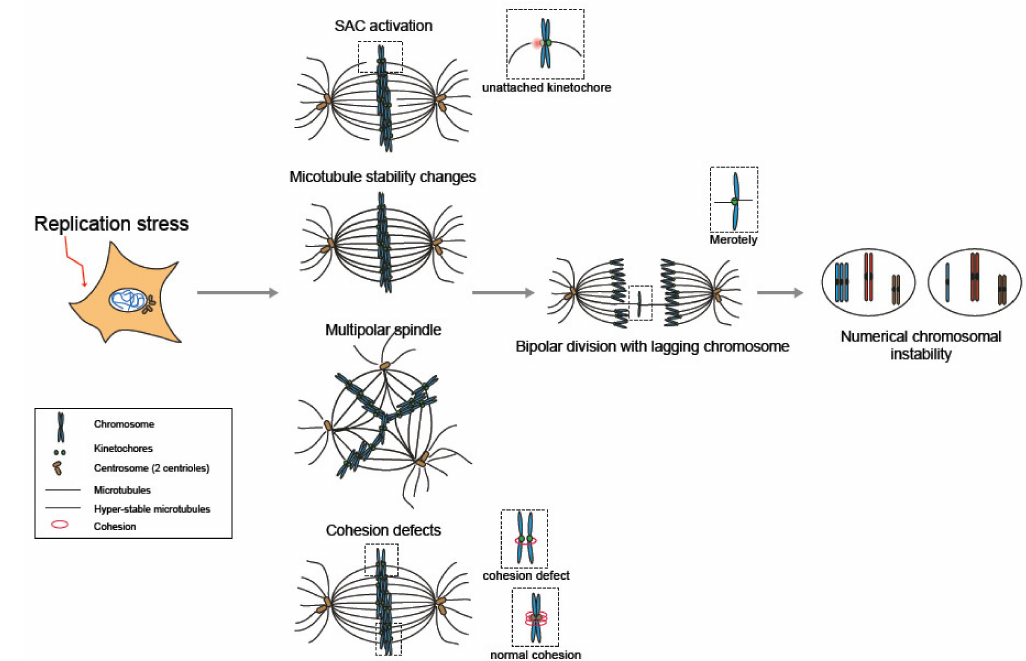
Figure 2. The impact of replication stress on the mitotic process. Diagram summarizing the type of mitotic dysfunctions occurring after replication stress. Replication stress can induce nonattached kinetochores and activate the spindle assembly checkpoint (SAC), change microtubule stability, induce multiple spindle poles due to centriole disengagement and lead to cohesion defects. SAC override might contribute to the mis-segregation of chromosomes with wrongly attached kinetochores. Changes in microtubule stability could lead to impaired error corrections that rely on the dynamic instability of microtubules. Multipolarity can occur transiently, because centrioles within one centrosome split before spindle poles cluster back together. Cohesion can be prematurely relieved at the centromere, which can induce chromosome mal-attachments because of altered kinetochore geometry. Wrongly attached kinetochores that are less e ffi ciently corrected can favor merotelically attached chromatids, where microtubules of opposing spindle poles attach to the same kinetochore. Such chromatid appears as lagging in-between the two segregating DNA masses and can be either reintegrated into the correct daughter cell, integrated into the wrong daughter cell (thus leading to aneuploidy) or get enclosed by its own nuclear envelope